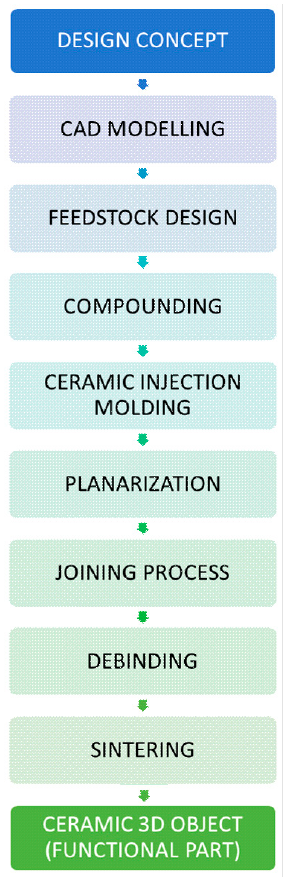
Figure 1. Process flow of the alumina µ-reactors production via ceramic injection molding (CIM) technology.